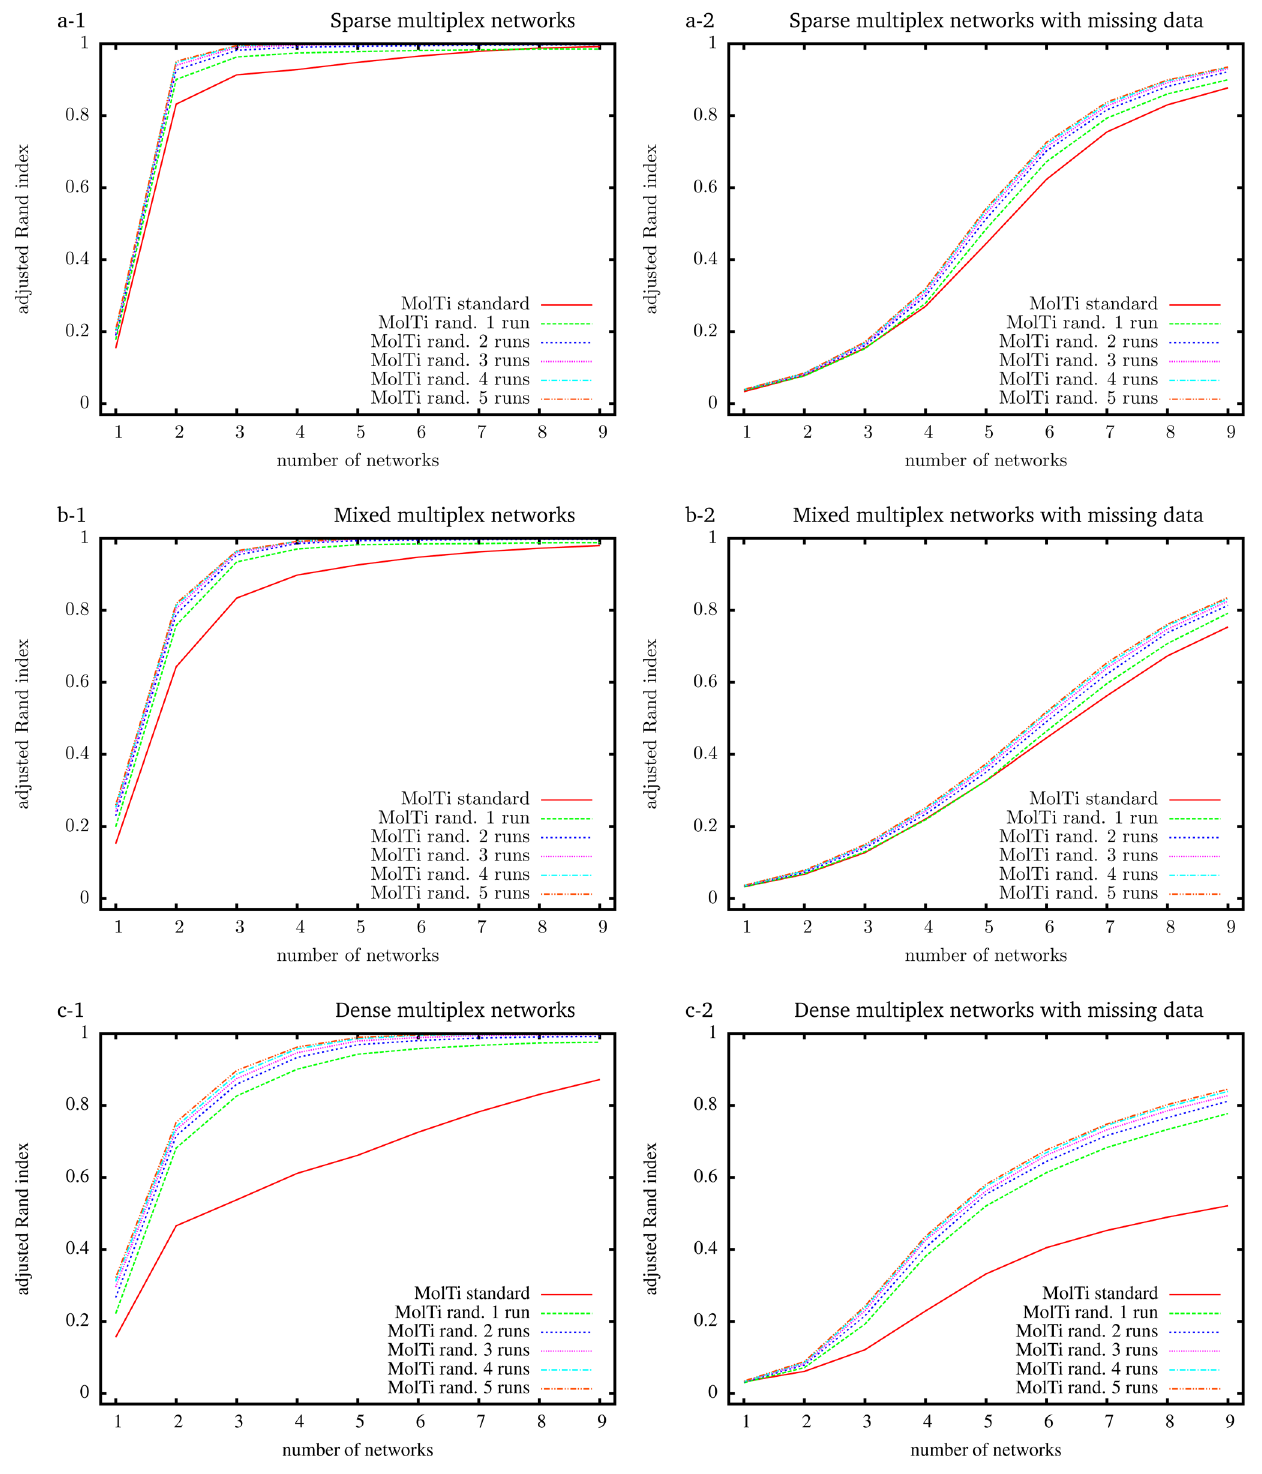
Figure 1. Adjusted Rand indexes between the reference community structure used to generate the random multiplex networks, and the communities detected by standard and randomized MolTi with 1 to 5 randomization runs. Multiplex networks contain from 1 to 9 graph layers. The indexes are averaged over 2,000 random multiplex networks of 1,000 vertices and 20 balanced communities. Each layer of sparse (resp. dense) multiplex networks is simulated with 0.1/0.01 (resp. 0.5/0.2) internal/external edge probabilities. Mixed multiplex networks are simulated by uniformly sampling each layer among these two pairs of edge probabilities. Multiplex networks with missing data (right column) are generated by removing vertices from each layer with probability